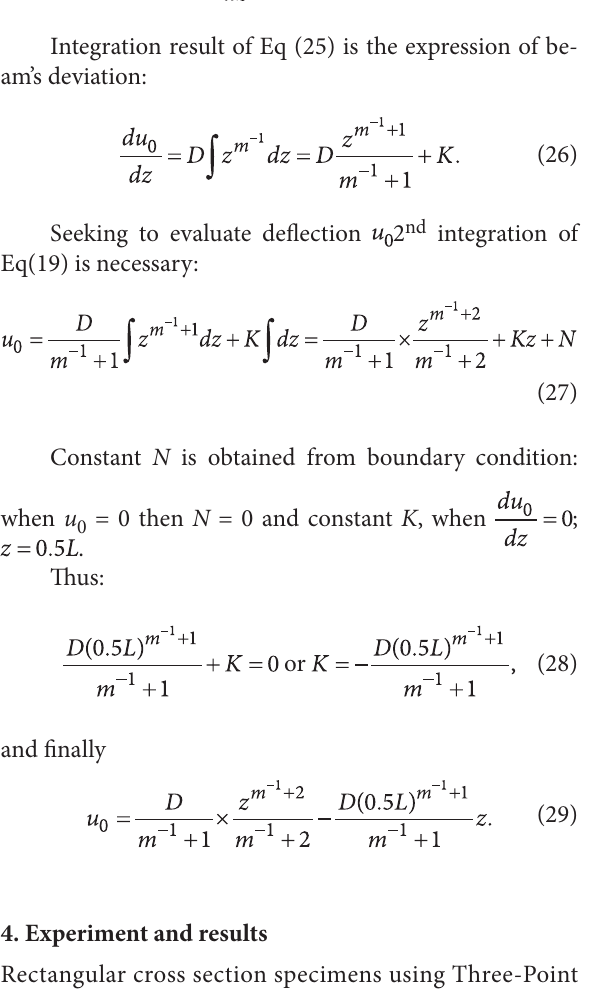
Fig. 3. Relationship between J s - integral and specimen‘s heigth H